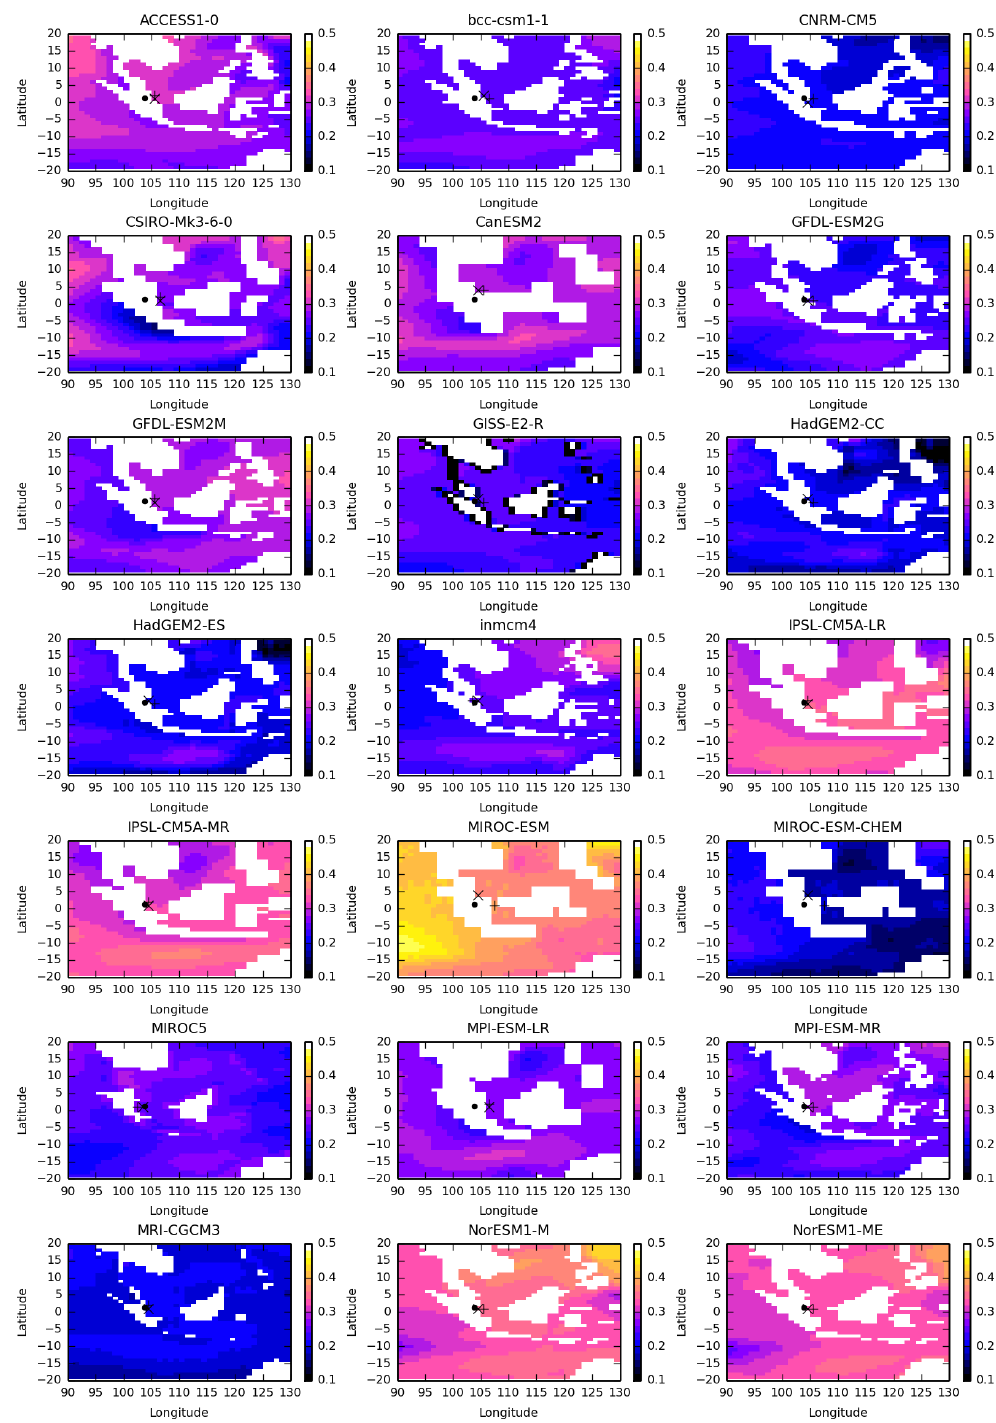
Figure 3. Projections of steric/dynamic sea level rise (metres) for 21 CMIP5 models under RCP8.5, computed as the difference between 1986–2005 and 2081–2100. The location of Singapore is shown by the black circle. The primary and secondary grid boxes used to extract time-mean sea level for Singapore are shown by an × and + , respectively. Note the grid box selections for GISS-E2-R are away from potential problem areas for the land